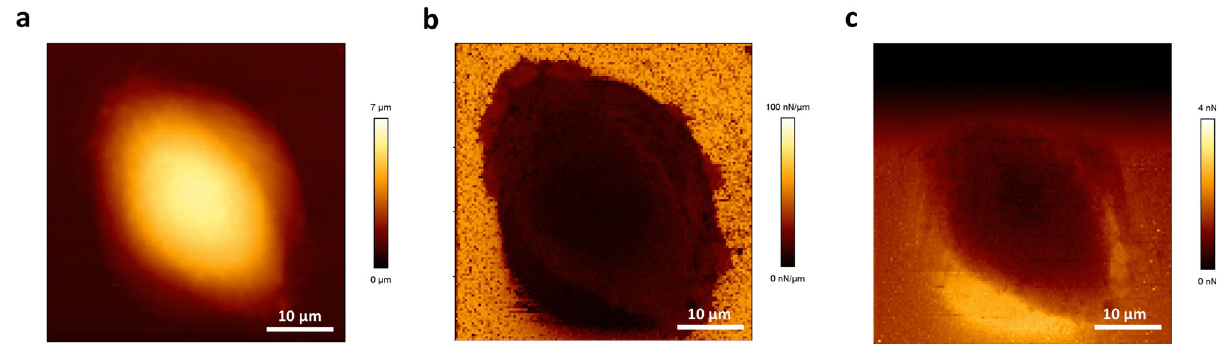
Fig. 2 AFM imaging of human vaginal epithelial VK2/E6E7 cells in the QI TM . a Height image based on the contact point position, b spring constant map corresponding to the slope of the approach force-distance curves, and c adhesion map corresponding to the maximum adhesion force on the retraction